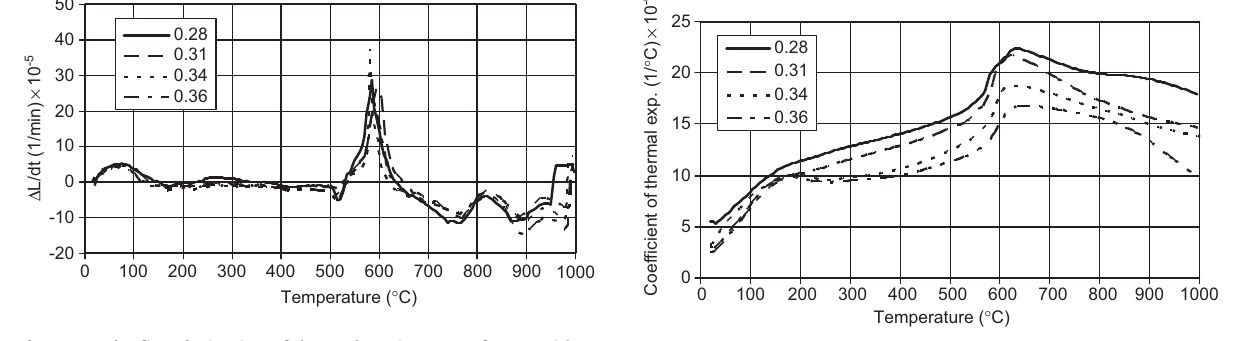
Figure 11 CTE of SCC vs.